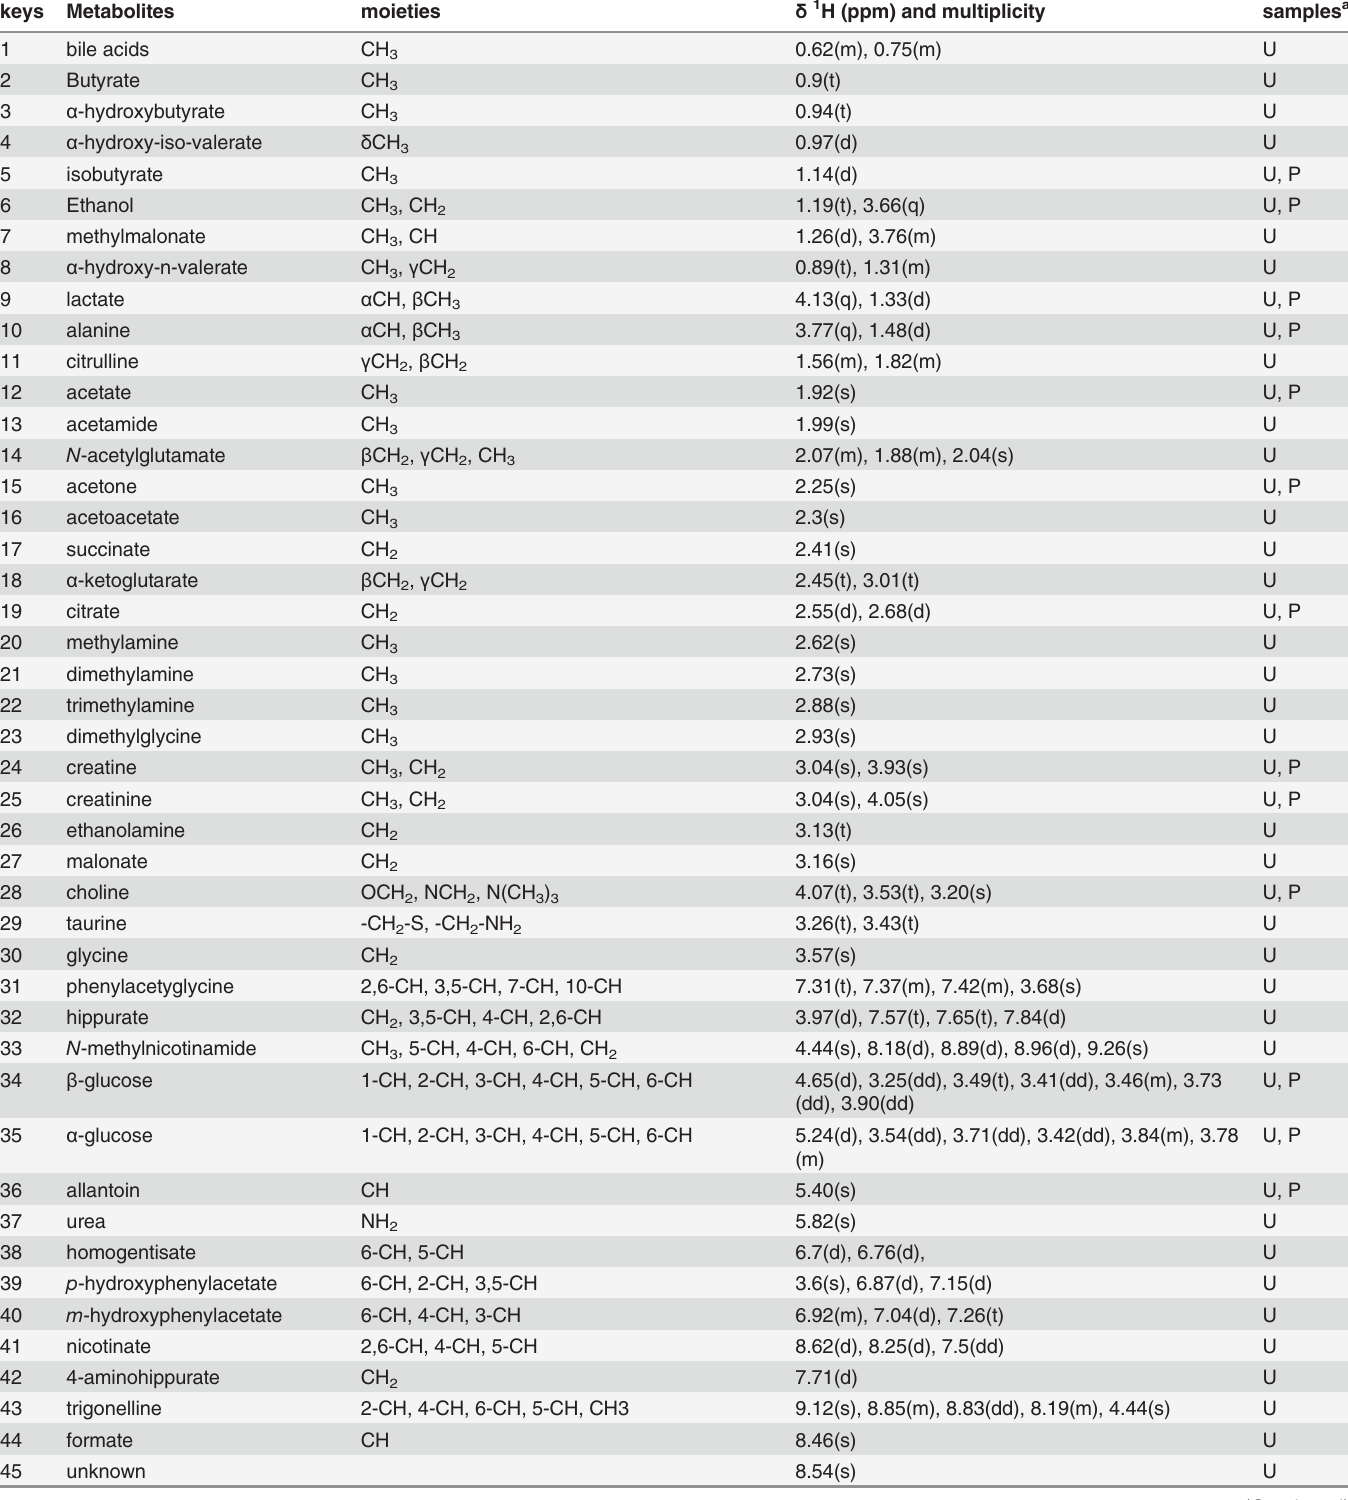
Table 5. 1 H NMR data for metabolites in rat urine and